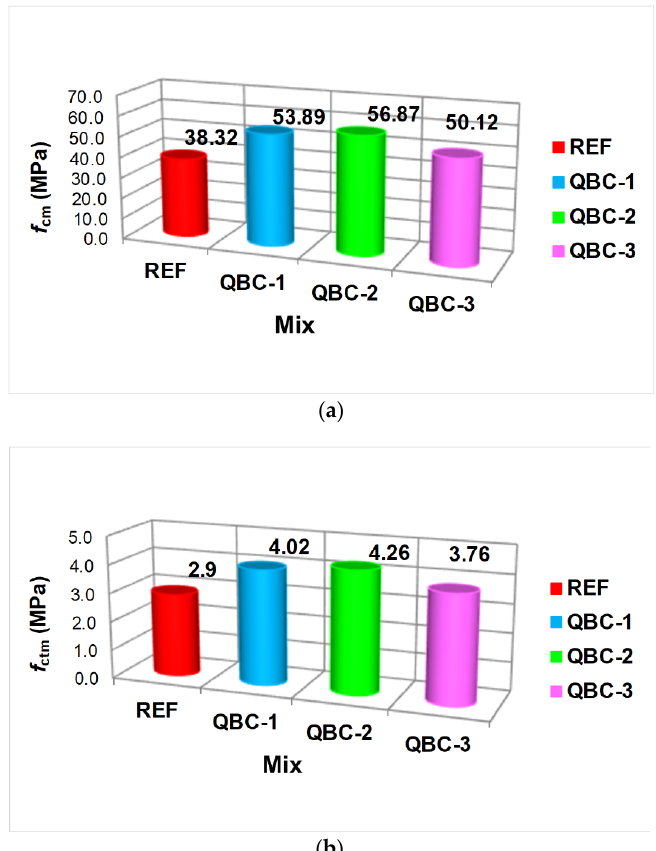
Figure 2. The results of the analyzed mechanical parameters of the concrete composites: ( a ) compressive strength, ( b ) splitting tensile